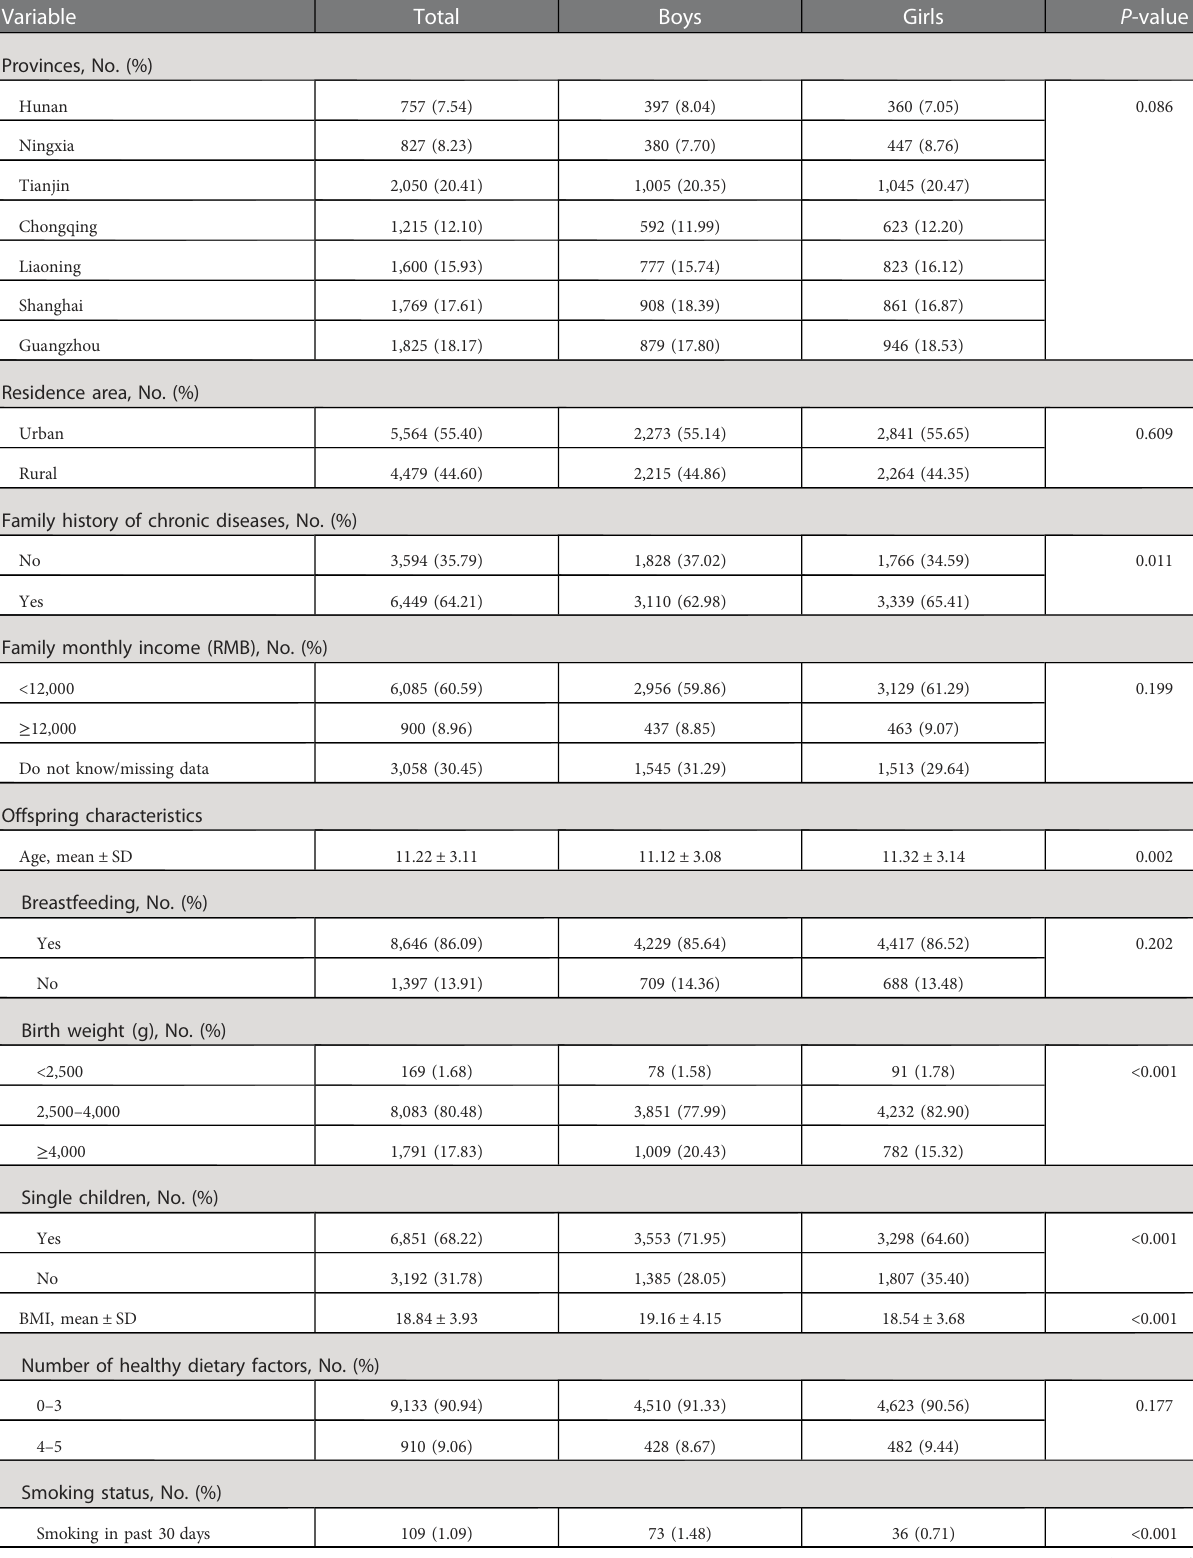
TABLE 1 Descriptive characteristics of the study population strati fi ed by sex.